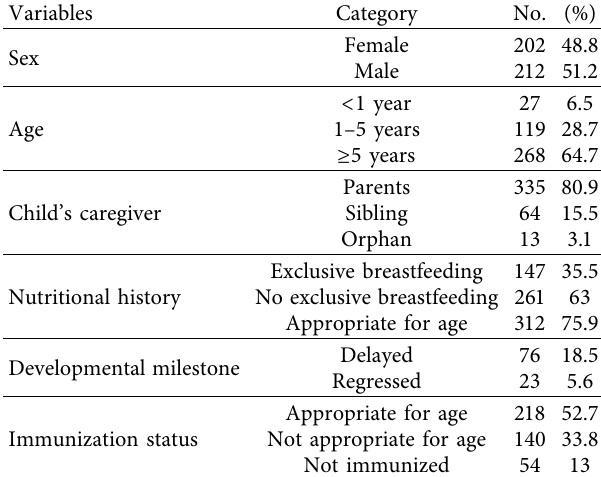
Table 1: Sociodemographic characteristics of children who started ART at public health facilities between January 1, 2011, to De-